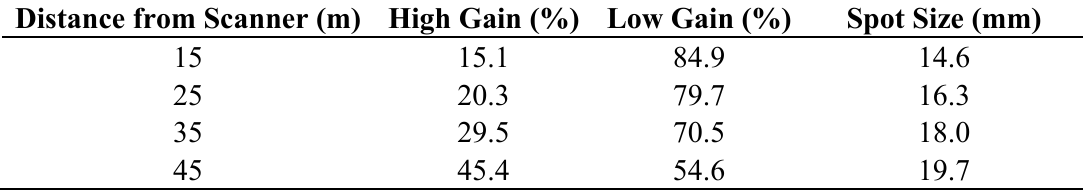
Table 2. Proportion of total returns for Douglas-fir branch scans recorded by the high gain and low gain receivers across a series of ranges (and spot